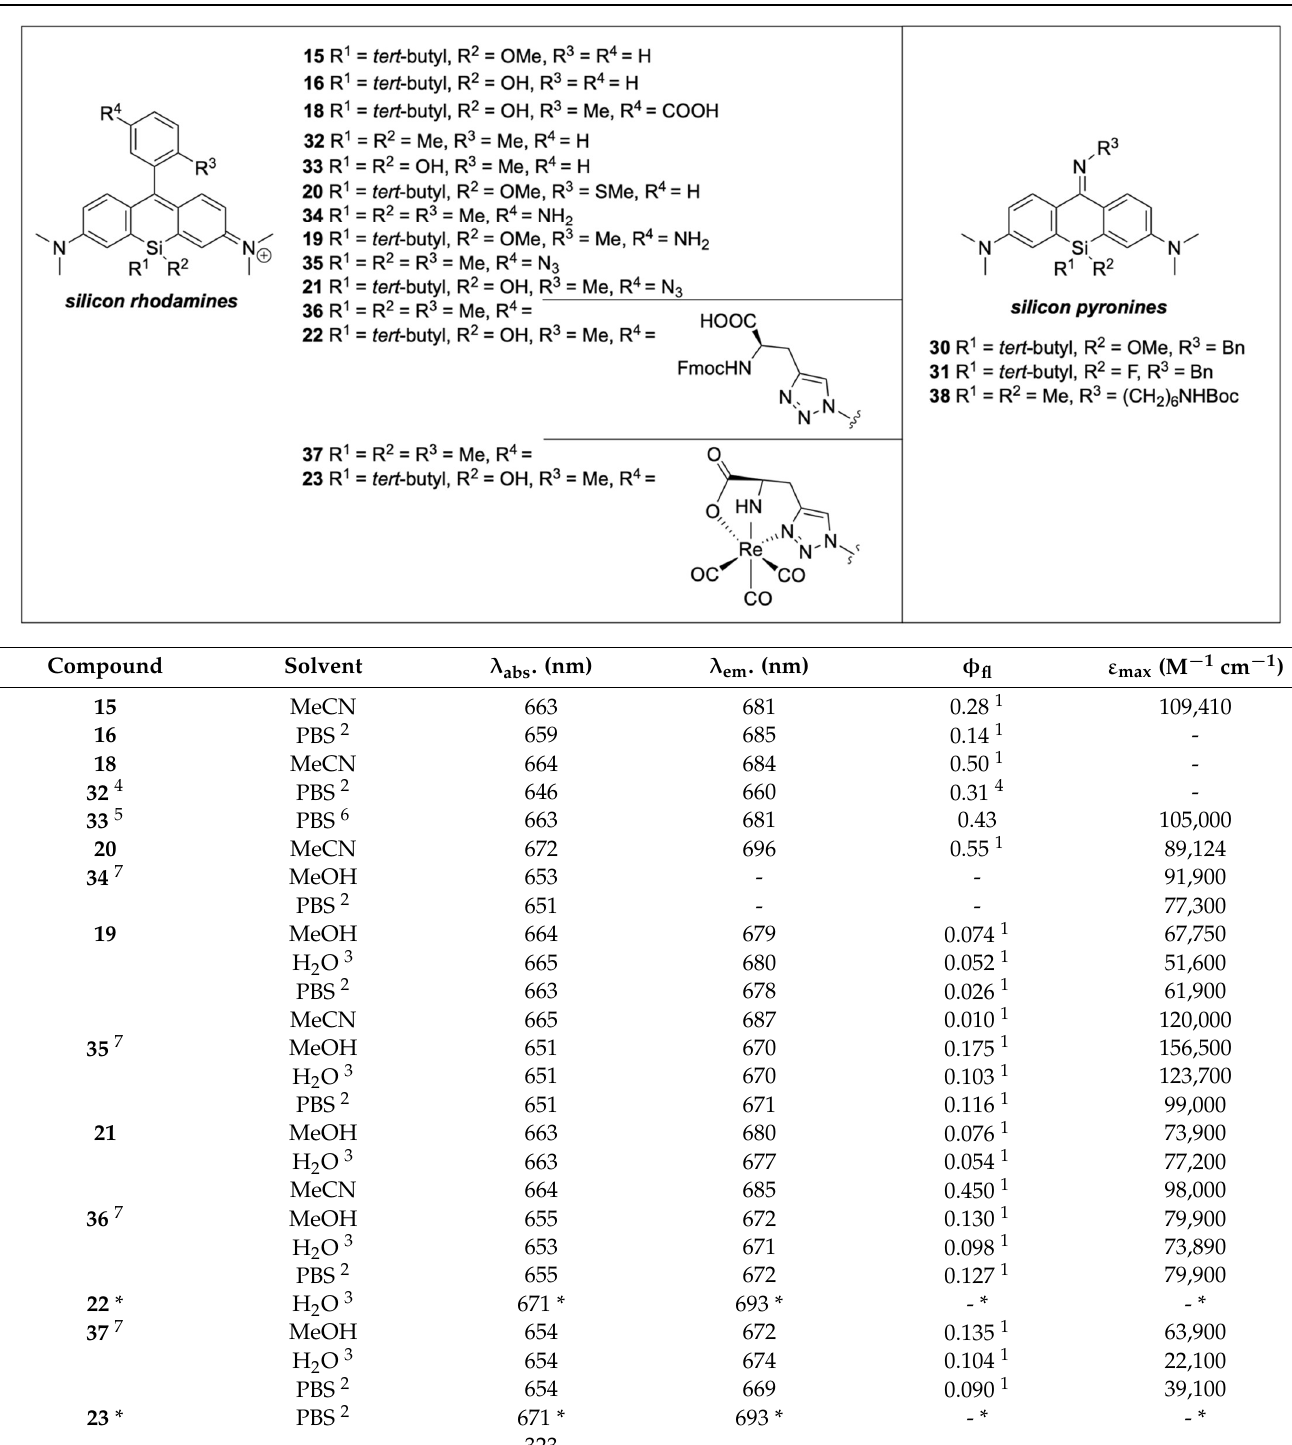
Table 1. Optical data of SiRs and pyronines.